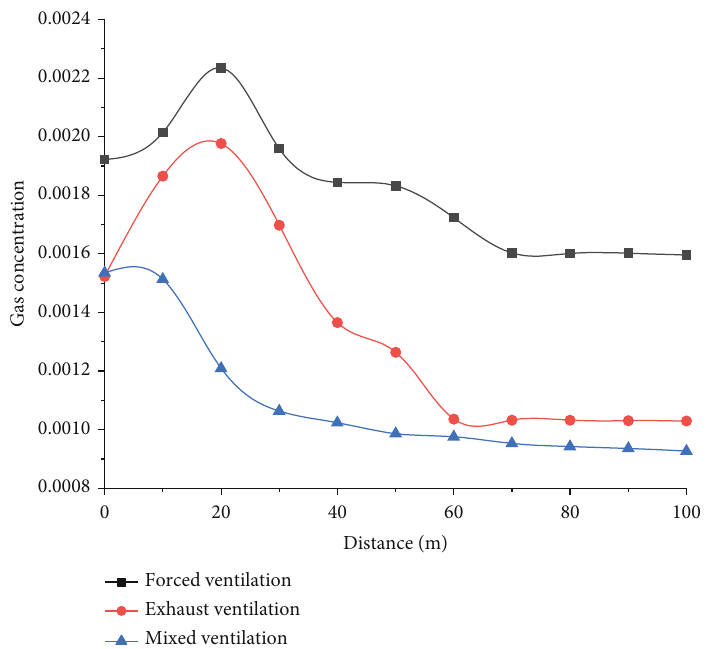
Figure 7: Variation curve of gas concentration in a tunnel under three ventilation